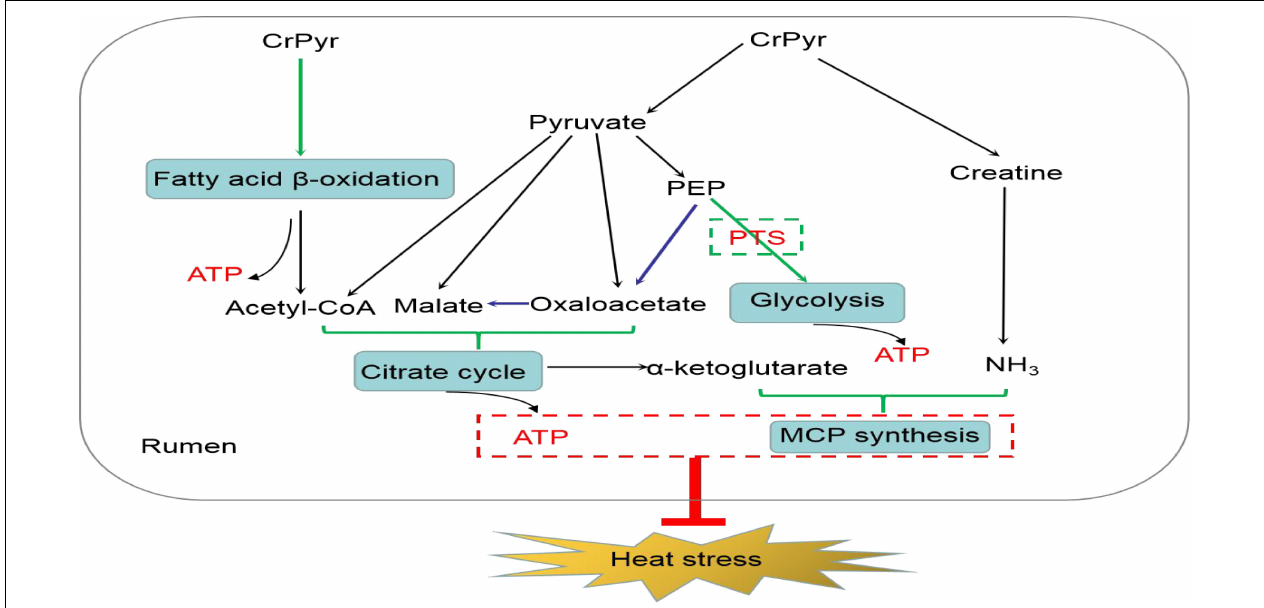
FIGURE 8 | Proposed model of creatine pyruvate relieving heat stress in rumen of beef